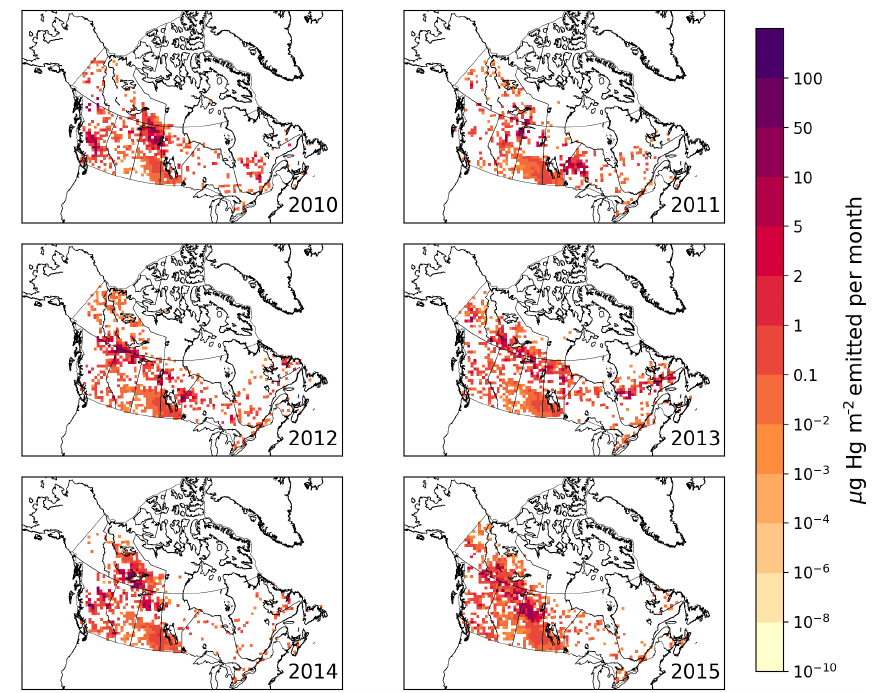
Figure 7. Mercury emissions from biomass burning (prior emissions) in Canada for 2010–2015, given in µgm − 2 month, averaged over the burning season (May–September). Point source emissions were aggregated to 60km grid.